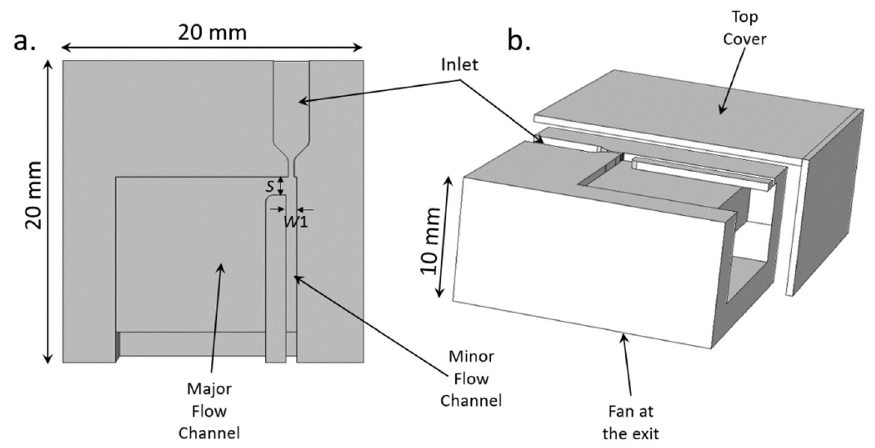
Figure 6. Dimensions of the complete system. ( a ) Top view, showing the minor and the major flow channels. ( b ) 3D schematic with the top cover removed to show the microchannels and the location of the external fan.